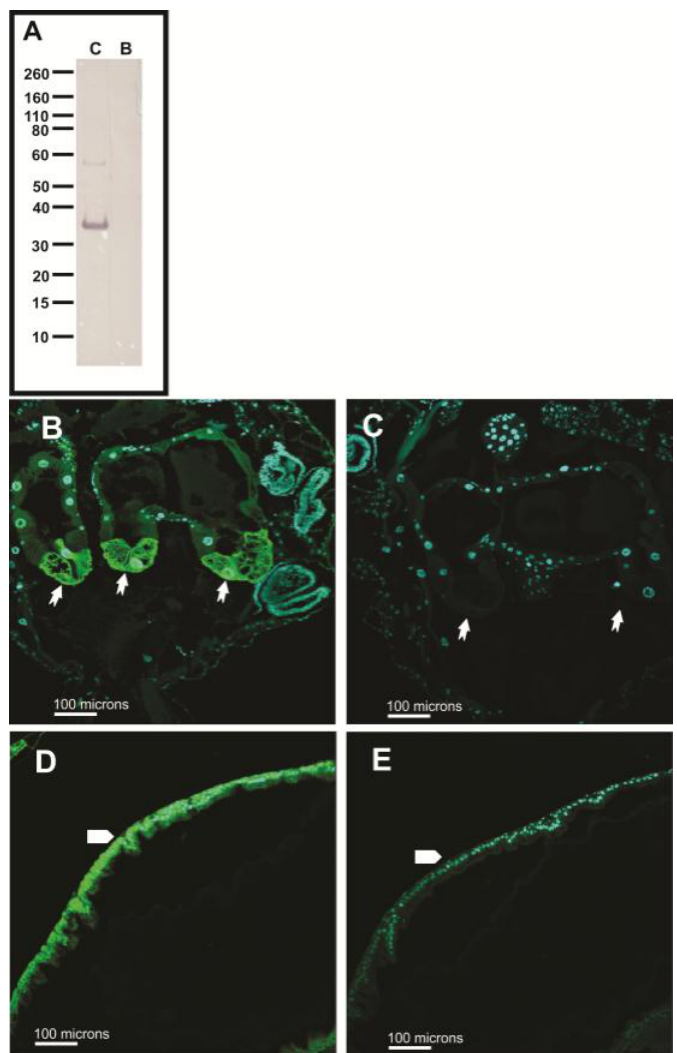
Figure 11. Pre-absorption controls of AeCA9 antibody targeting larvae and adults. In this figure, the AeCA9 primary antibody was pre-absorbed with its associated peptide to determine its specificity in larvae and adults. ( A ) The protein used in the western blot is isolated PMG protein. Non-absorbed antiserum targeted lane C (control), while absorbed antiserum targeted lane B (blocked/absorbed). AeCA9 is around 32 kDa. AeCA9 was detected using the control antiserum, and the blocked antiserum did not detect AeCA9; ( B – E ) In the sections, either larval GC ( B & C ) or the adult PMG ( D & E ) were targeted. The same antibody solution sets were used in the control ( B & D ) and blocked ( C & E ) tissue sections and western blots. In both the larval GC and adult PMG, AeCA9 signal was blocked after preabsorption with the peptide. In the larval GC, arrows indicate cap cells. In the adult PMG, the arrows represent the epithelial cells of the PMG. The green signal is for AeCA9 while the cyan signal is for DAPI.